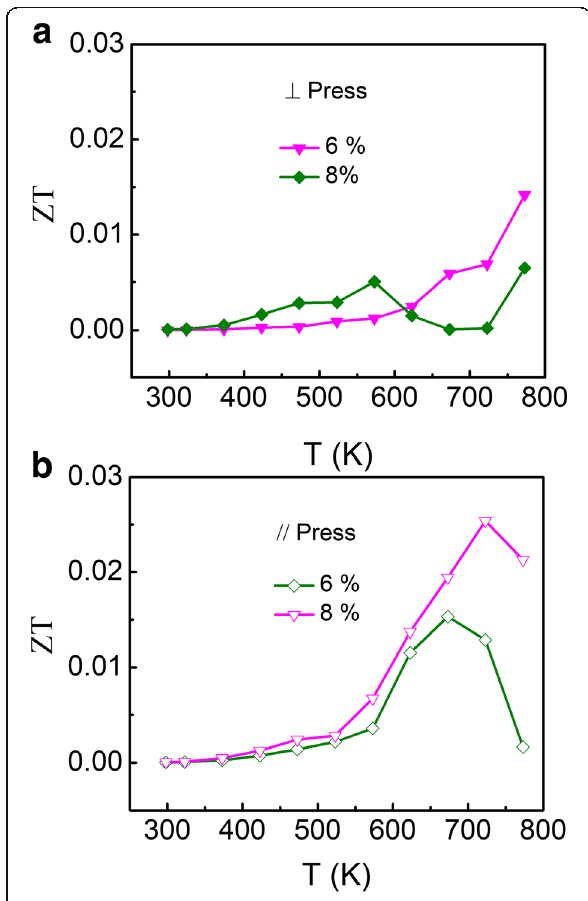
Fig. 5 (Color online) Temperature dependence of dimensionless thermoelectric figure of merit of polycrystalline SnSe:Bi 6% and SnSe:Bi 8% samples along both ⊥ ( a ) and // ( b )